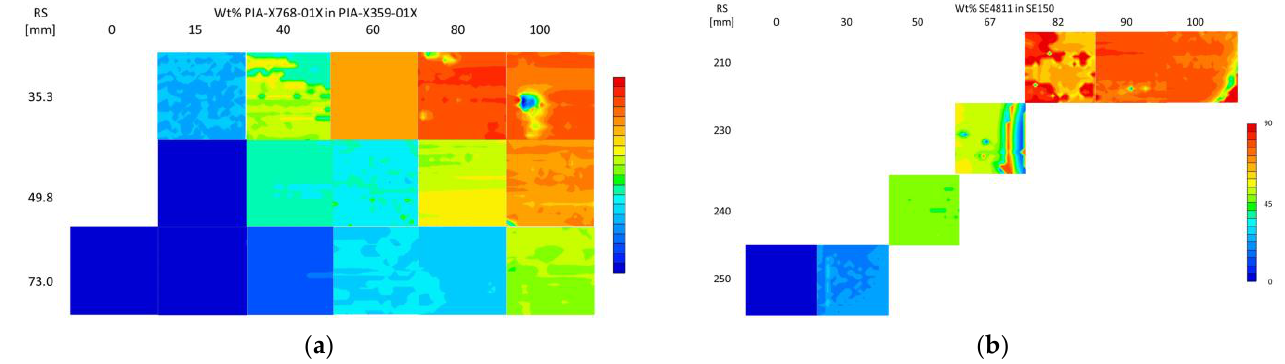
Figure 6. Pretilt angle mappings over an area of 10.2 mm 2 for ( a ) PIA-X768-01X and PIA-X359-01X and ( b ) SE-4811 and SE-150.